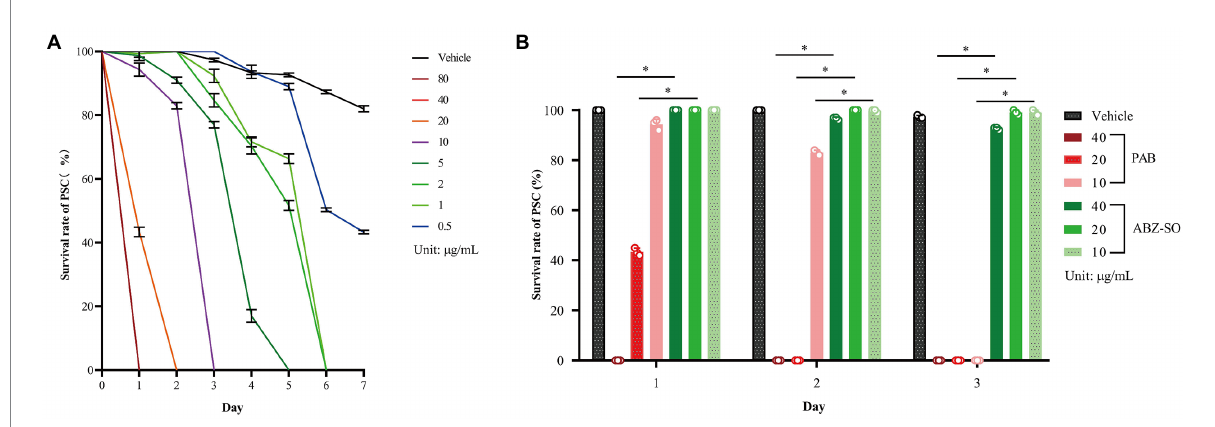
FIGURE 1 Changes in survival rate of E. multilocularis PSC before and after PAB treatment in vitro . (A) Survival rate of E. multilocularis PSC of the vehicle group exposed to 0.5–80 μ g/ml PAB for 7 days, and (B) 10, 20 and 40 μ g/ml PAB and ABZ-SO for 3 days, as measured by morphological alterations under a light microscope. Data are expressed as mean ± SD, n = 3. The independent experiments were processed in